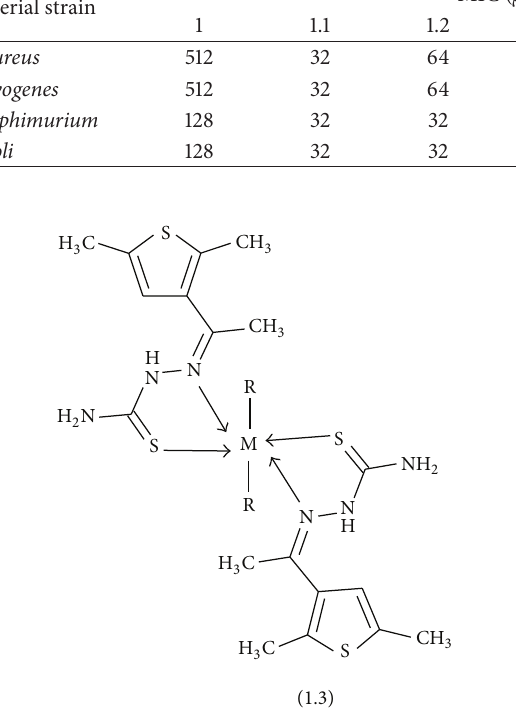
Table 2: Minimum inhibition concentration (MIC) of thiosemicarbazone and its metal complexes. Bacterial strain